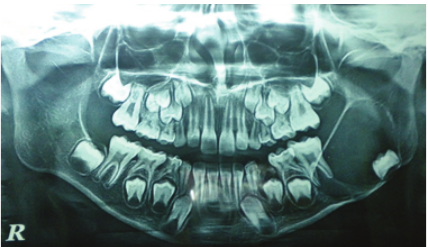
Figure1:OPGshowingwell-definedunilocularradiolucencyonthe left side of the mandible.